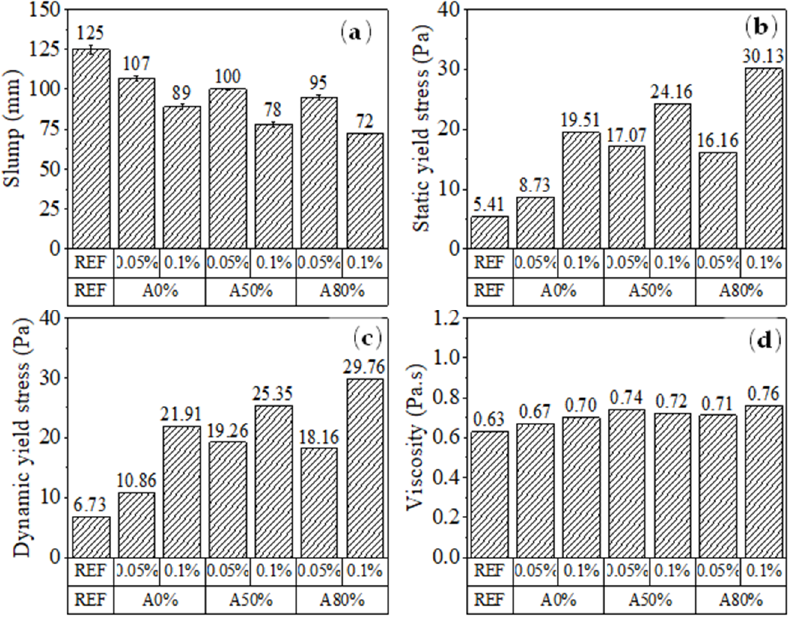
Figure 8. Rheological parameters of CNT cementitious composites: ( a ) slump; ( b ) static and ( c ) yield stresses, and ( d ) dynamic yield stresses, and ( d ) viscosity.